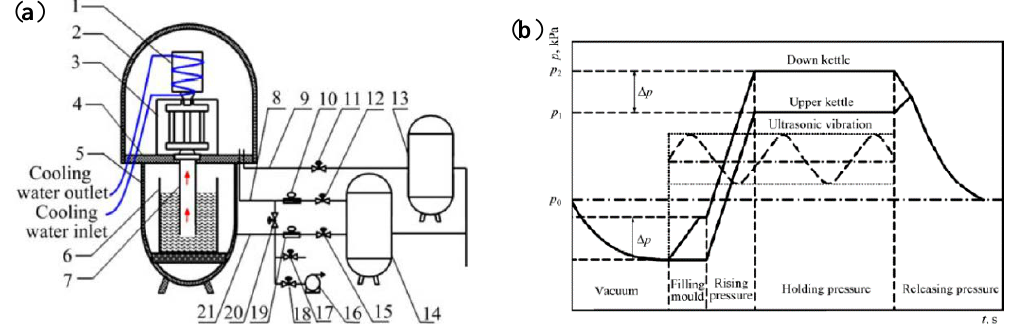
Figure 1. Equipment and technical schematic of synergistic action between ultrasonic vibration and vacuum counter-pressure: ( a ) equipment, 1—ultrasonic device, 2—upper kettle, 3—mould, 4—clapboard, 5—down kettle, 6—crucible, 7—rising tube, 8, 9, 21—gas tube, 10, 19—regulating valve,